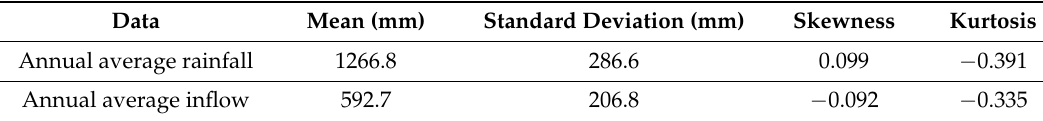
Table 2. Statistical characteristics of the two collected data series.